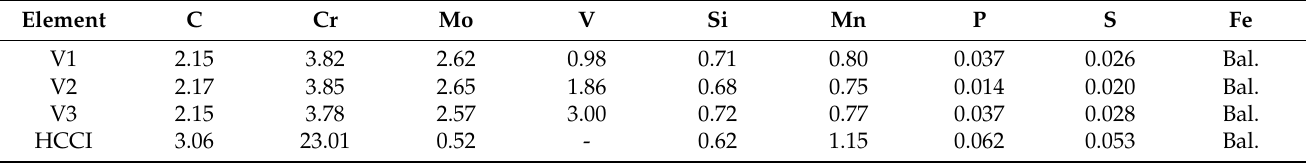
Table 1. Chemical compositions of low-vanadium wear-resistant alloys and HCCI (weight percent).